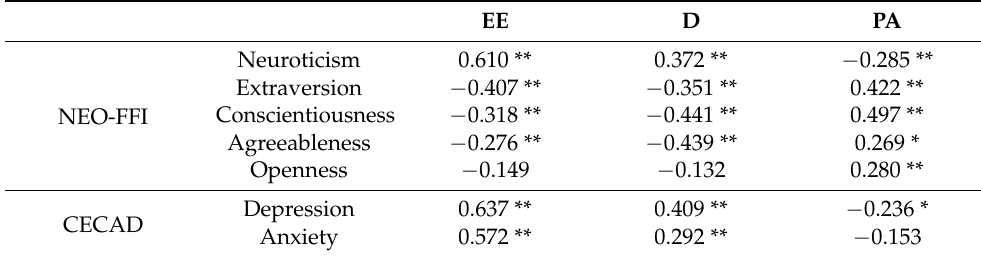
Table 5. Coefficient of correlation between psychological variables and